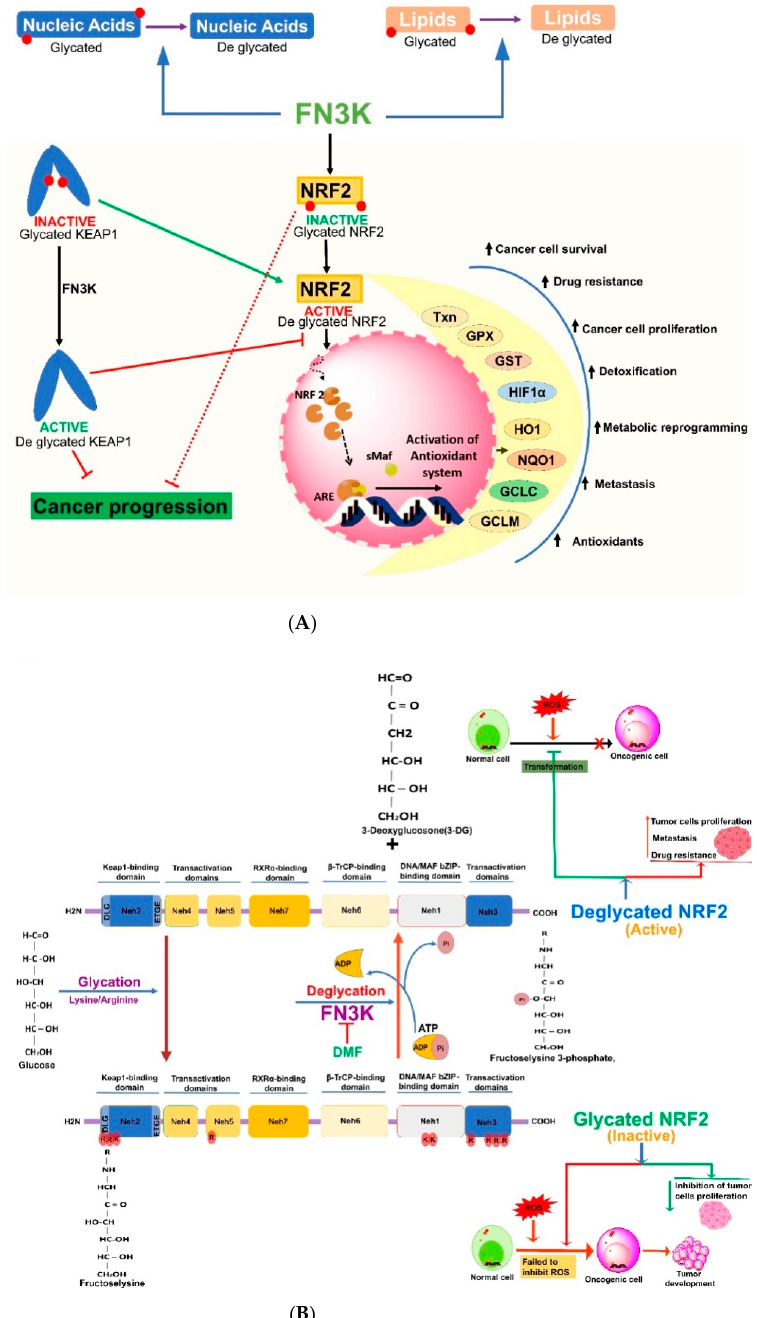
Figure 3. ( A ) Signaling pathways involved in the regulation of Nrf2: Oncogenic Nrf2 signaling is regulated by glycation and deglycation mechanisms in cancer cells. The redox regulator Nrf2 is an oncogenic transcription factor involved in controlling cellular oxidative stress, cell proliferation, migration, drug resistance, and metastasis. Nrf2 and its negative regulator Keap1 are controlled by glycation and deglycation mechanisms. ( B ) Schematic representation of glycated Nrf2: Glycated Nrf2 containing various binding domains from Neh1 to Neh7 where glycation occurs (indicated in small red circles) is depicted in this schematic representation. FN3K is a deglycating enzyme reported to promote functionally activate the Nrf2 level in cancer cells and enhance cancer progression. Fructolysine residues of glycated Nrf2 react with ATP and get converted into a phosphorylated form in the presence of FN3K. The blockade of FN3K could promote the formation of glycated Nrf2 and mitigation in oncogenicity and cancer progression. Txn—thioredoxin, GST—glutathione